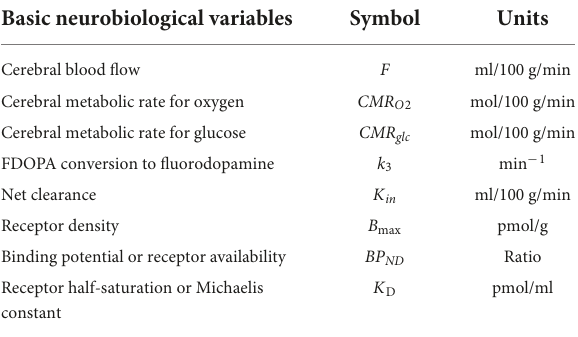
TABLE 1 Basic neurobiological variables and